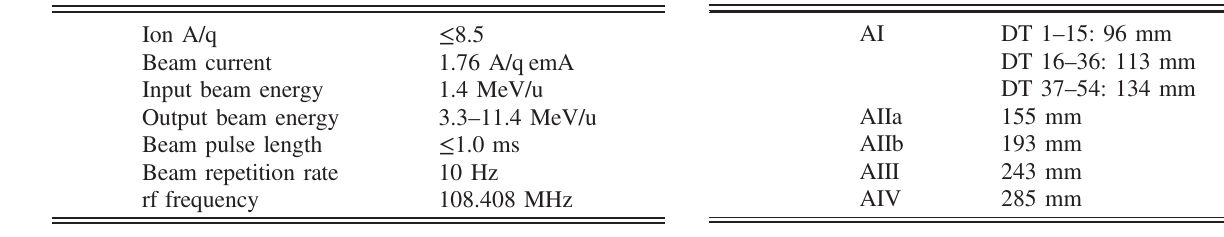
TABLE I. Main parameters of the new poststripper DTL. Its design was used for simulations with 2.0 mA of protons.